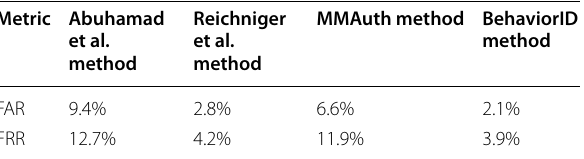
Table 6 Estimated values of FAR and FRR during multifactor authentication for the case of long-term usage of a smartphone (SherLock dataset) Metric Abuhamad et